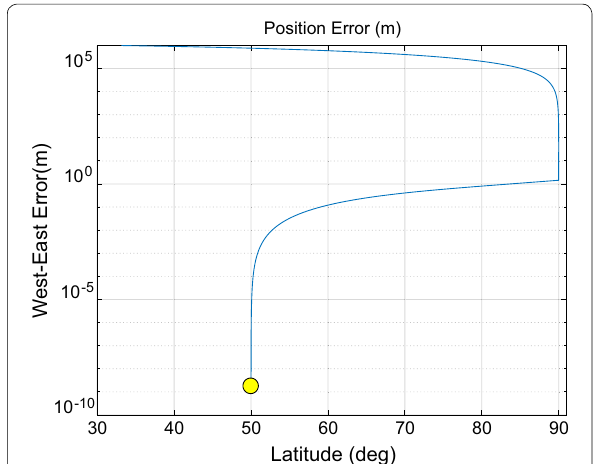
Fig. 5 Absolute west-east position errors versus true latitude of flight trajectory in local-level-frame